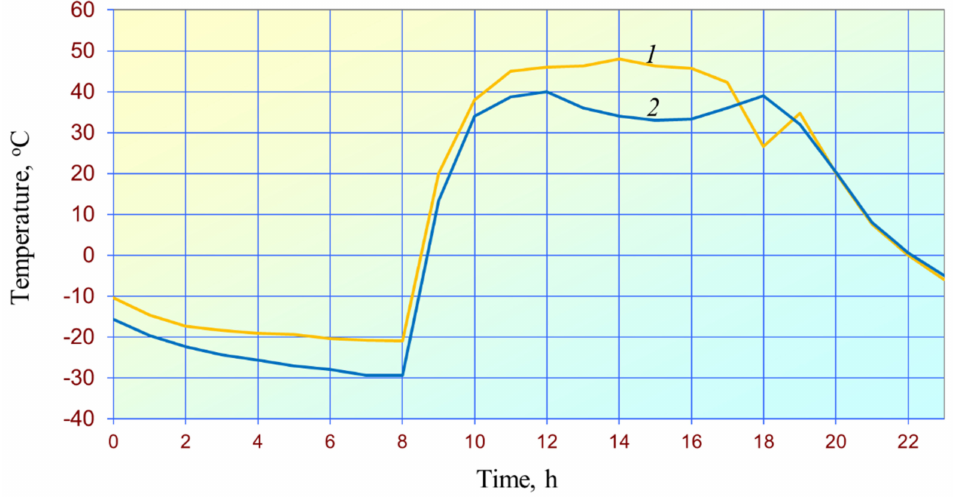
Figure 8. Time–temperature curves of evacuated collectors group 1 : 1 —on 15 March 2019 (sunny day); 2 —on 20 March 2019 (cloudy